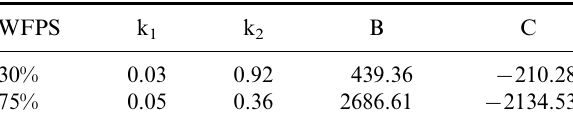
Table 1. Calculation of k 1 , k 2 , B and C values during incubation studies using Sorada soil samples by